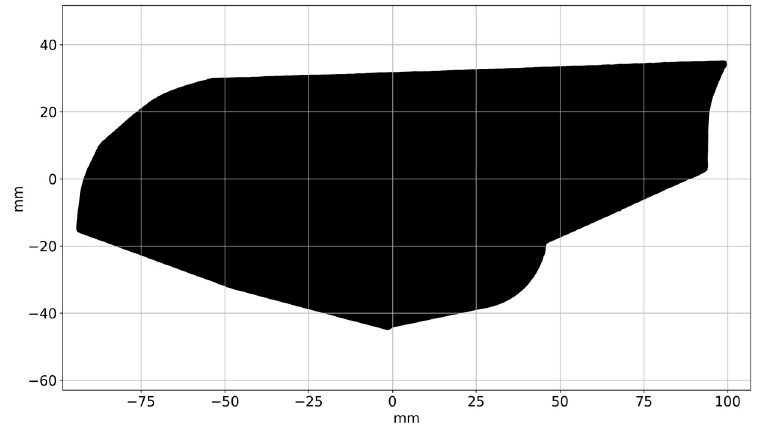
Figure 5. TA1 wing profile scan; area 10,804.6 mm 2 , centroid at origin.